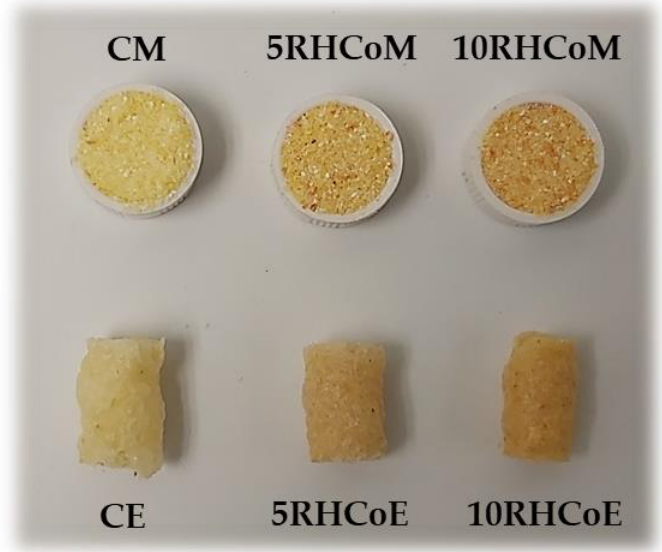
Figure 5. Appearance of studied mixtures (M) and extrudates (E); C: Control, 5RHCo: 5% of rosehip co-product and 10RHCo: 10% of rosehip co-product.